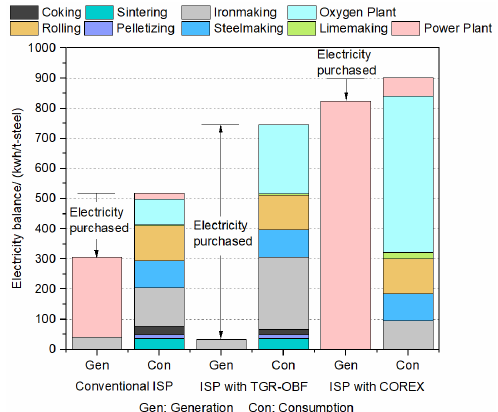
Figure 8. The electricity balance in the conventional ISP, the ISP with the TGR-OBF, and the ISP with the COREX.